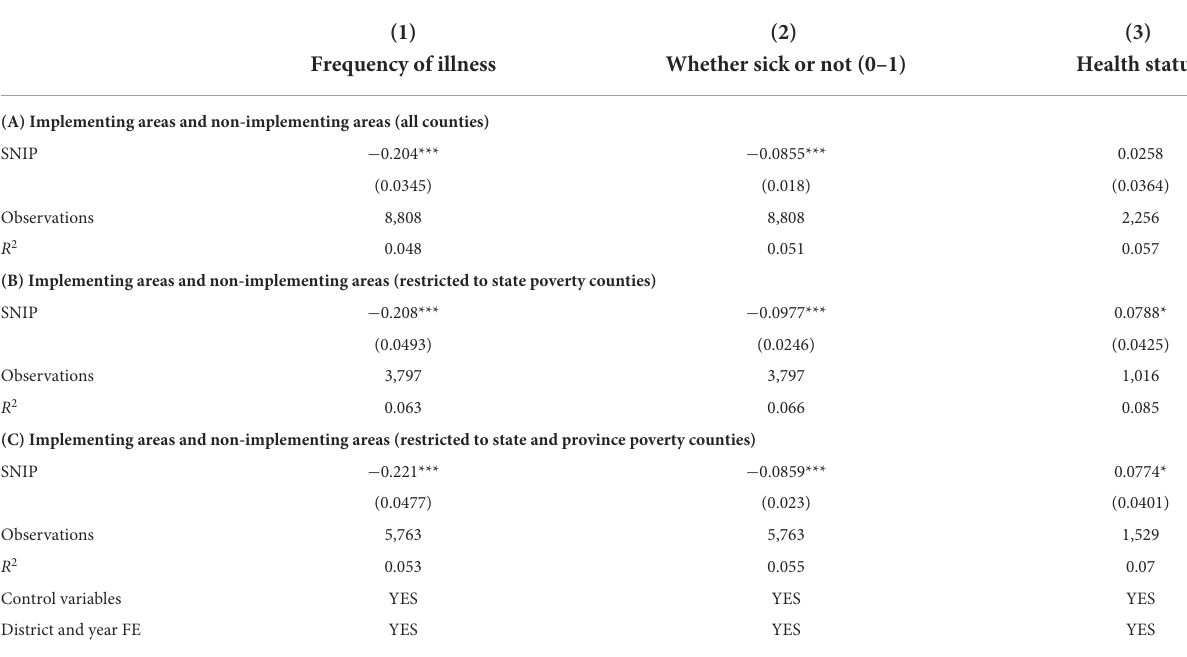
TABLE 3 Baseline analysis: Implementing areas and non-implementing areas of nutrition improvement